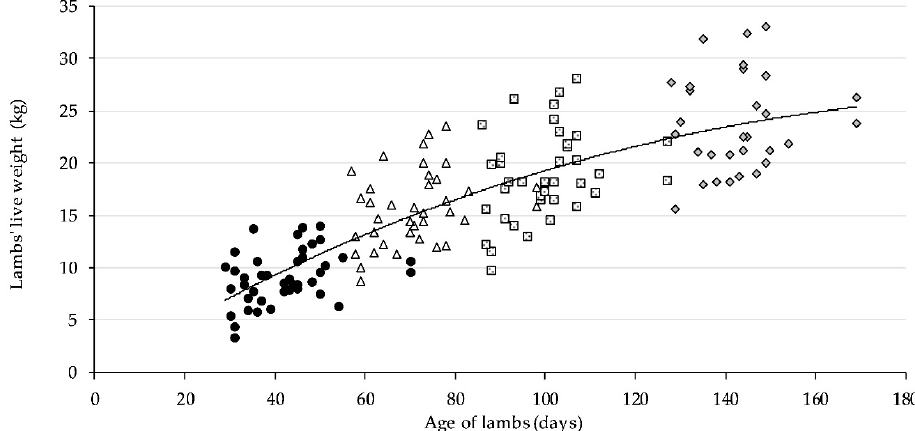
C 14:0 ; palmitic acid, C 16:0 ) contained in the SFA group showed a negative relation [25,26]. The e ff ect